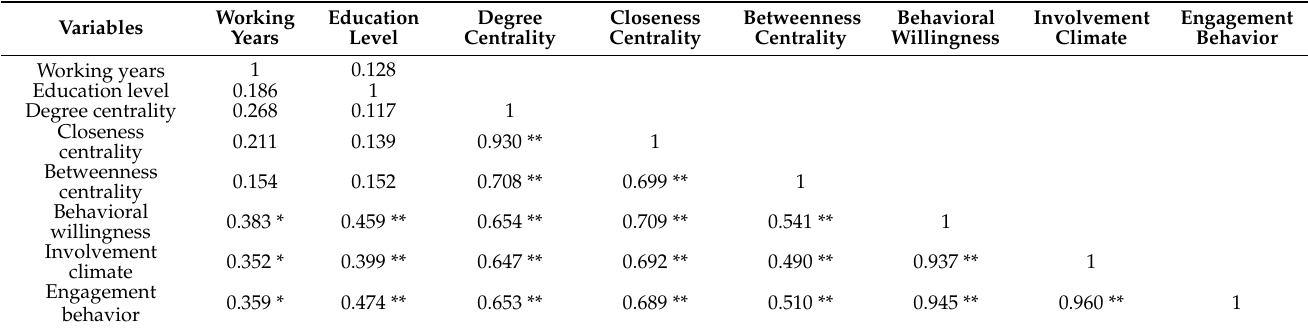
Table 6. Correlation analysis of